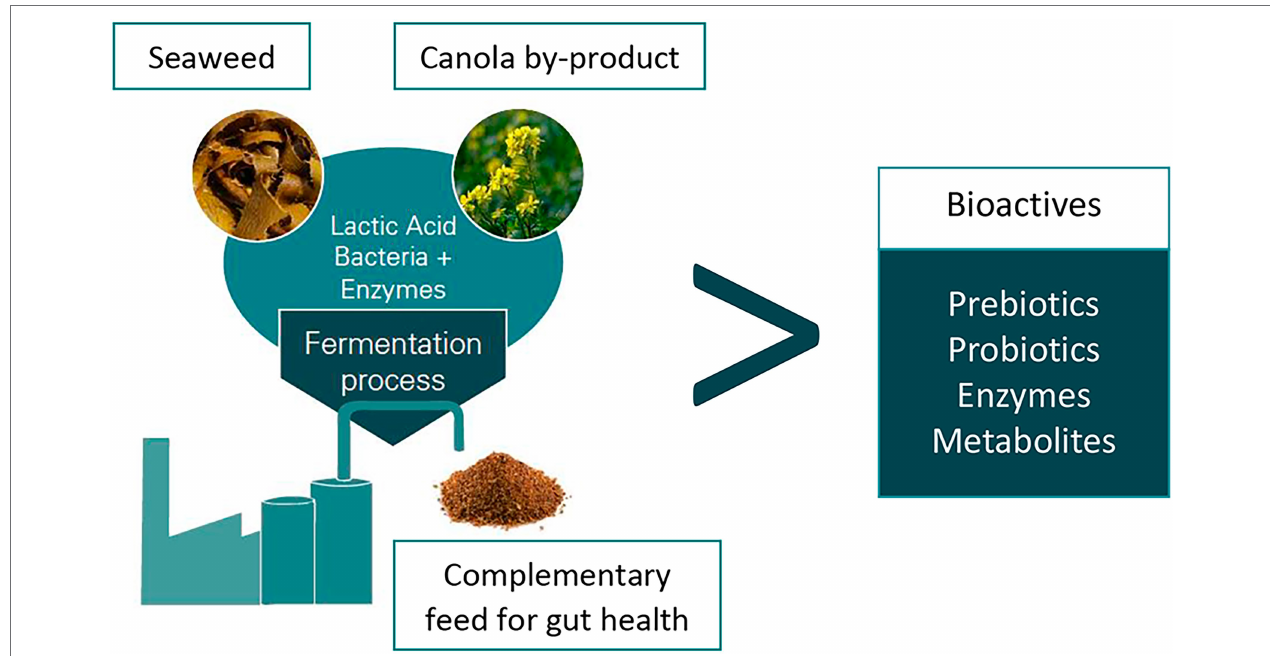
FIGURE 4 | Flowchart for production of the new feed additive EP199. Rapeseed meal and brown seaweed biomass are co-fermented by lactic acid bacteria